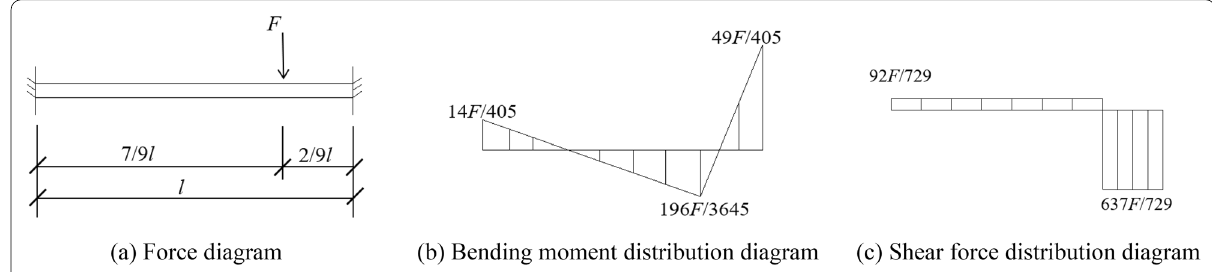
Fig. 19 Schematic diagram of the force of test members under static force.